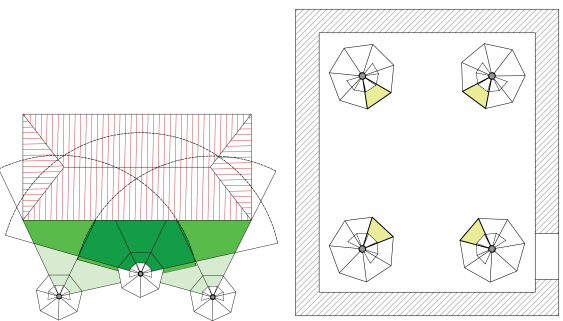
Figure 1: Typical measuring situation of the V10: for a fassade (left) and indoor (right).